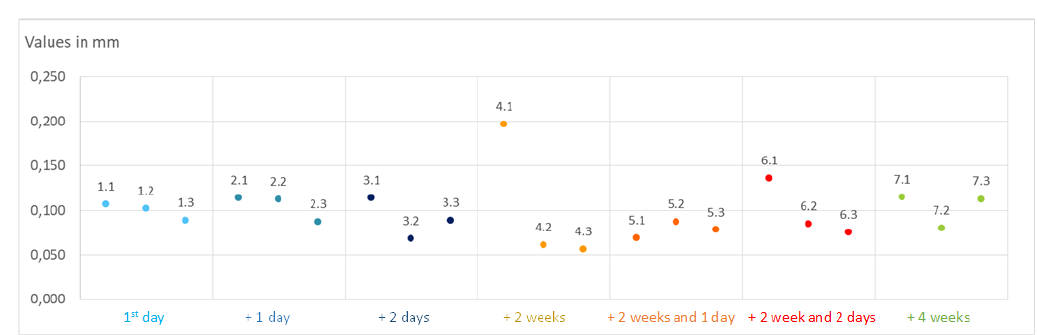
Figure 8. Deviations in y axis.